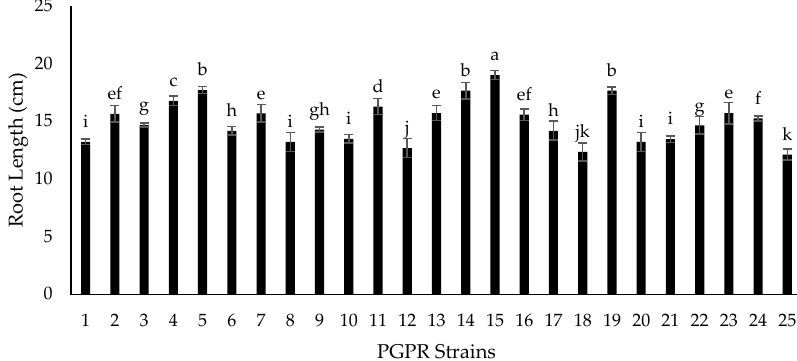
Figure 8. Effect of plant growth promoting rhizobacteria (PGPR) strains on chickpea root length (cm). Strains (1–24) are PGPRs (RS-01 to RS-24) while 25 is the control treatment. The bars indicate standard error ( ± SE) of the mean ( n = 3). Means followed by the same letter within the bars are not significantly different at p = 0.05.